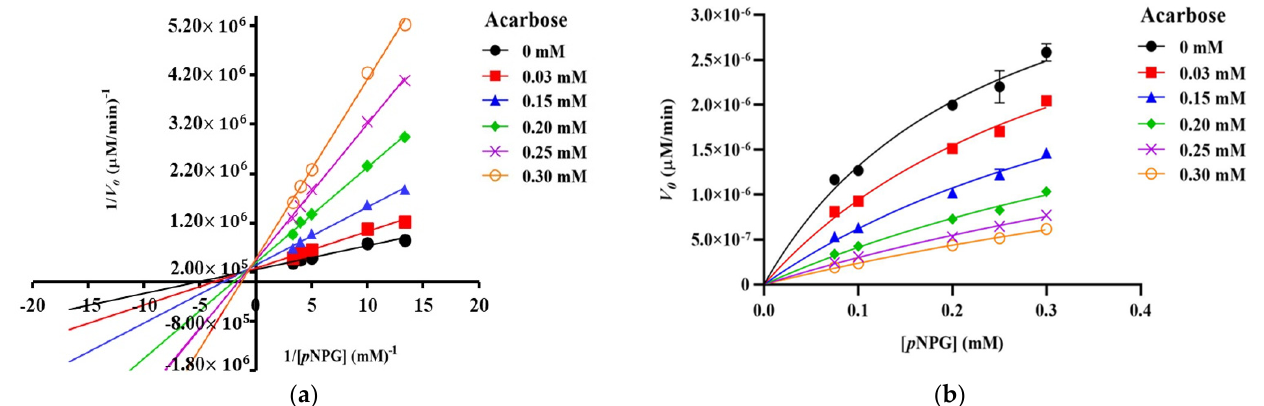
Figure 5. Kinetic analysis of α‐ glucosidase inhibition. ( a ) Lineweaver–Burk plot and ( b ) Michaelis– Menten plot of the inhibition kinetic by acarbose with different concentrations of p NPG. The values are given as mean ± SD ( n = 3).